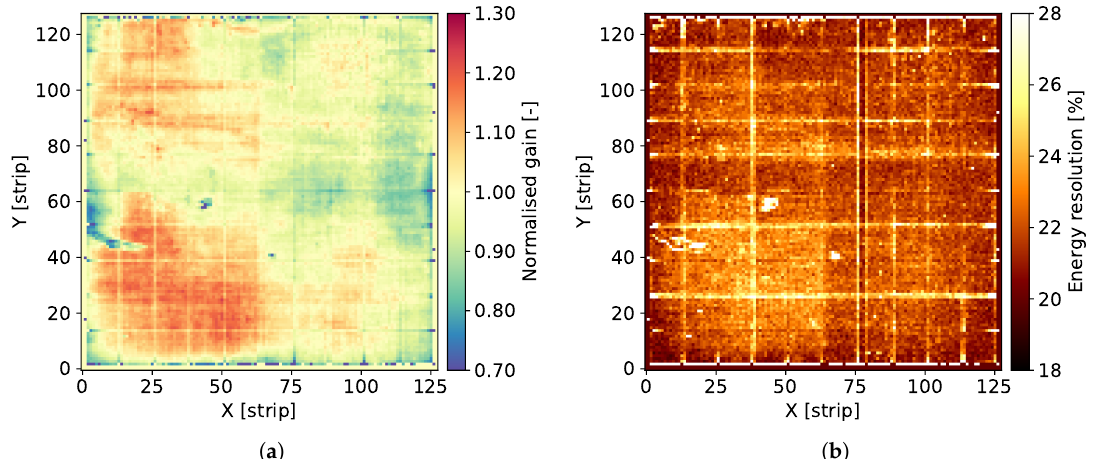
Figure 4. GEM detector A 2 . 2D maps of: ( a ) normalized gas gain; and ( b ) energy resolution for detector bias voltage of